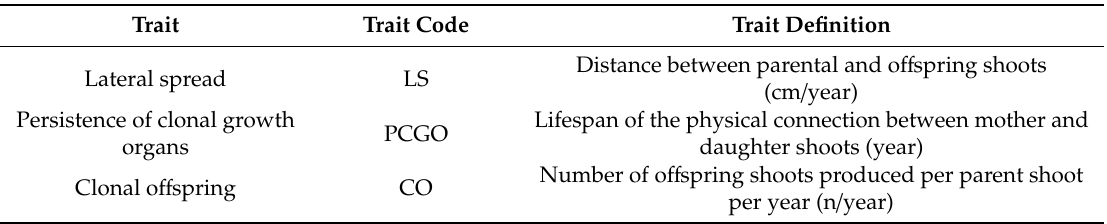
Table 1. List of plant clonal traits considered in this study, their codes and definitions present in CLOPLA3